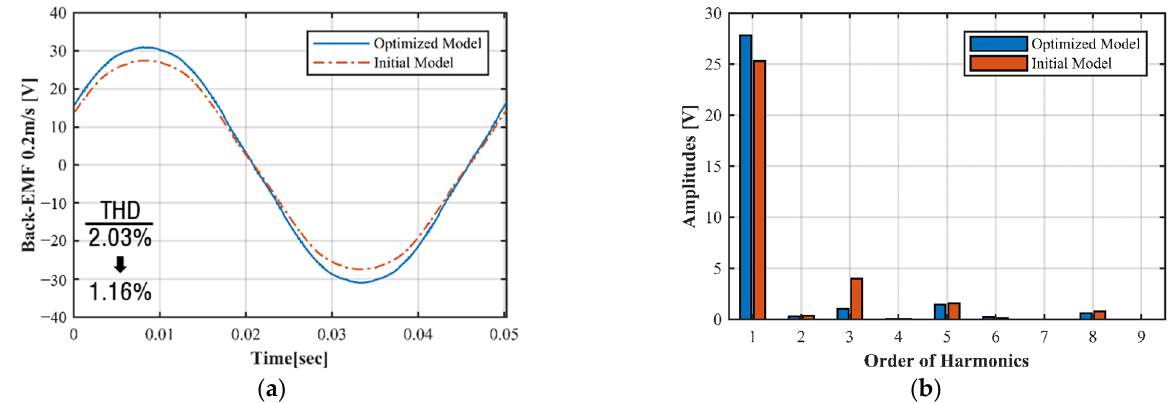
Figure 13. No-load voltage back EMF: ( a ) Back EMF of initial model; ( b ) Harmonic components of back EMF.